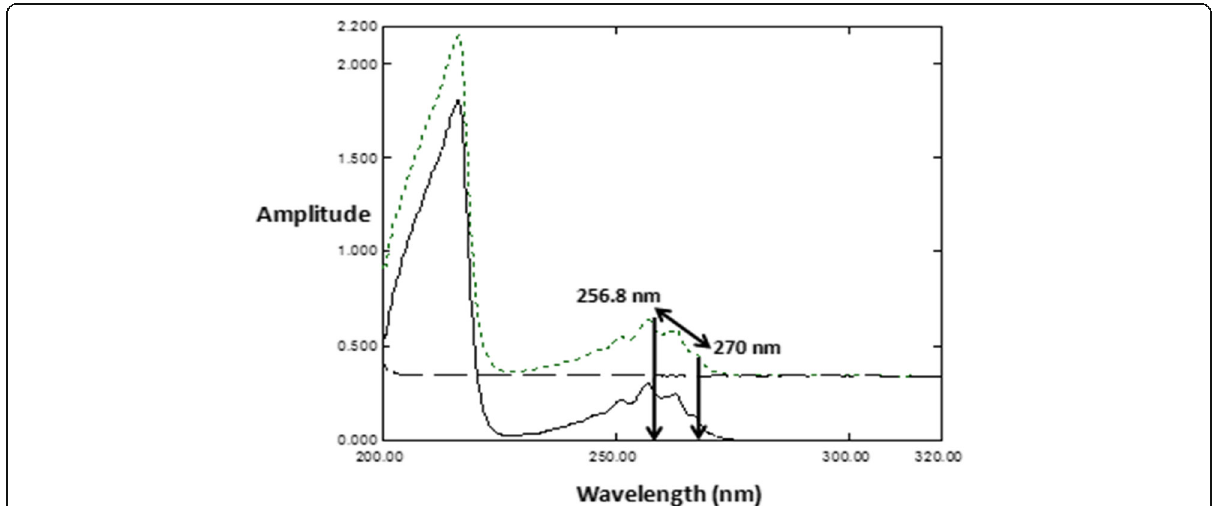
Fig. 6 The amplitude difference at 256.8nm and 270nm ( Δ P 256.8 -270nm) of ratio spectrum of binary mixture of PSE and LOR (s/b h), LOR (s/b i)